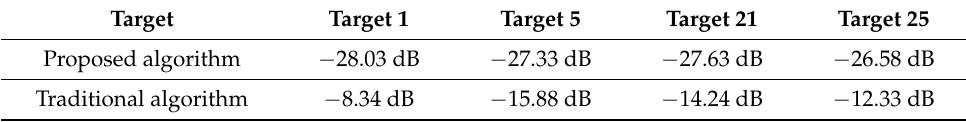
Table 4. Compensation results of the target 1, 5, 21, and